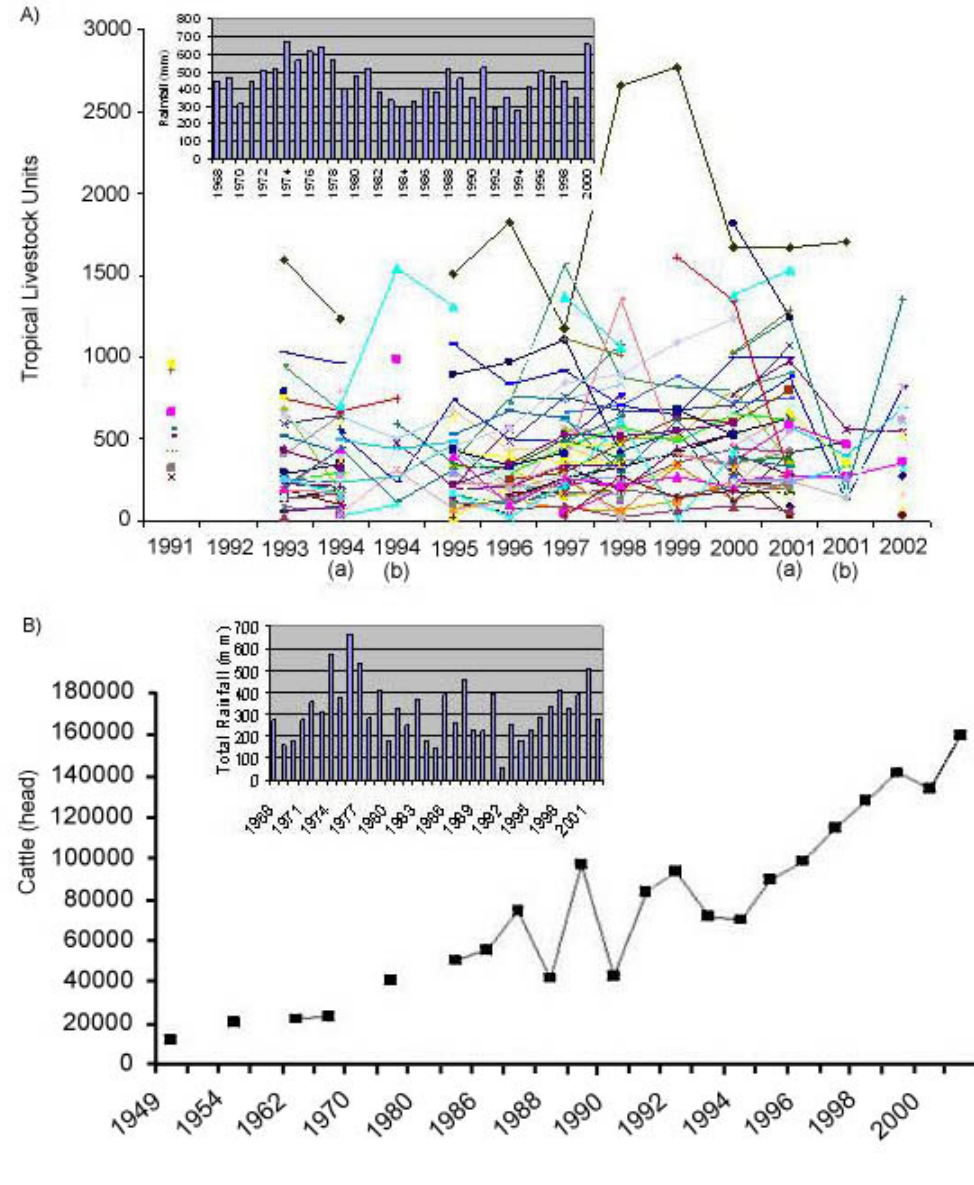
Fig. 4 . Communal land livestock holdings for A) an example 10 villages in Southern Kgalagadi District and B) Southern Kgalagadi District. Source: Republic of Botswana, Department of Agriculture Statsitics,